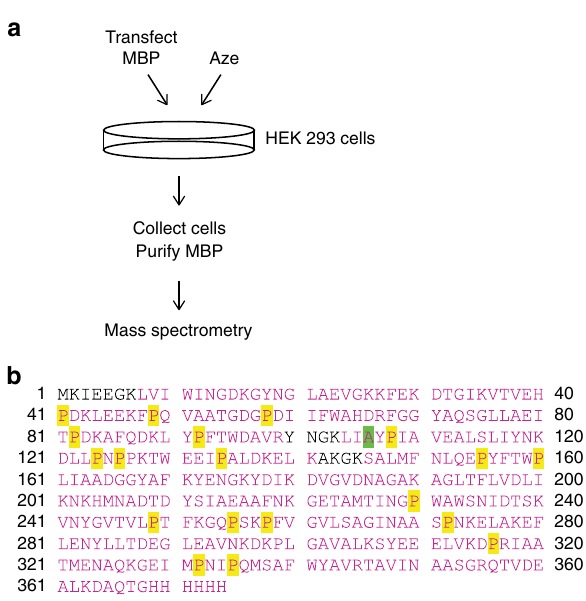
Fig. 3 Aze misincorporates into Pro positions of proteins. a Experimental procedure for detection of Aze misincorporation into proteins. b MBP sequence; 96% coverage by mass spectrometry analysis (sequence covered colored in magenta). Pro positions replaced by Aze highlighted in yellow, and the single Ala position replaced by Aze at a frequency of 0.024% highlighted in green